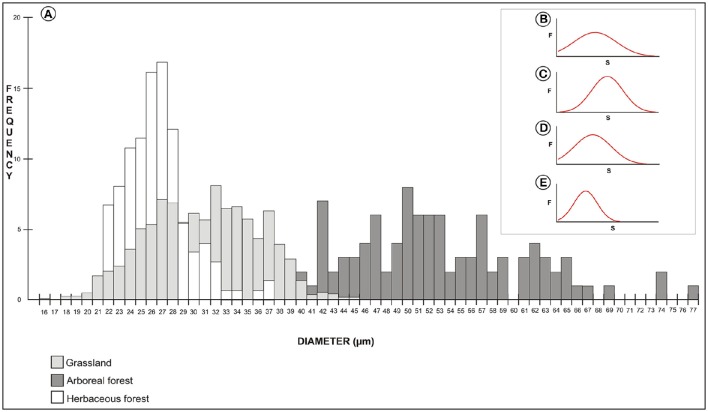
Frequency distribution histogram of the pollen size measurements (A). Gaussian distribution of size measurements of pollen grains of arboreous species (B), grassland species (C), herbaceous forest species (D), and all species studied (E). F, frequency; S, pollen grain size.